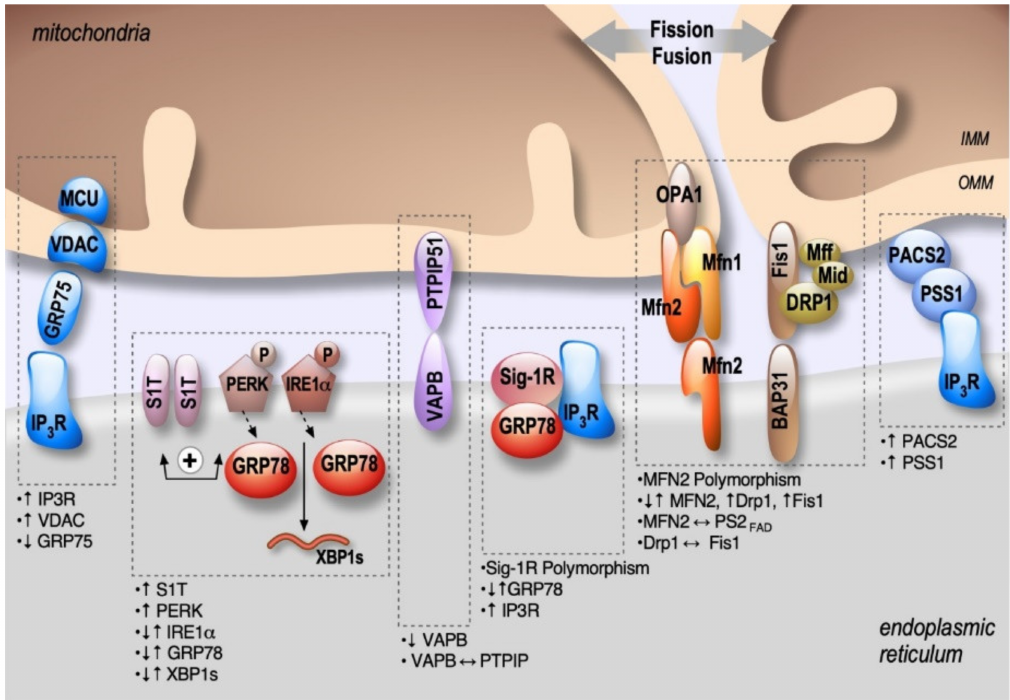
Figure 2. Schema showing the localization and alterations of MAMs molecular components in AD, including upregulation ( ↑ ) or down-regulation ( ↓ ) of MAMs proteins expression, MAMs proteins interactions ( ↔ ), and genes